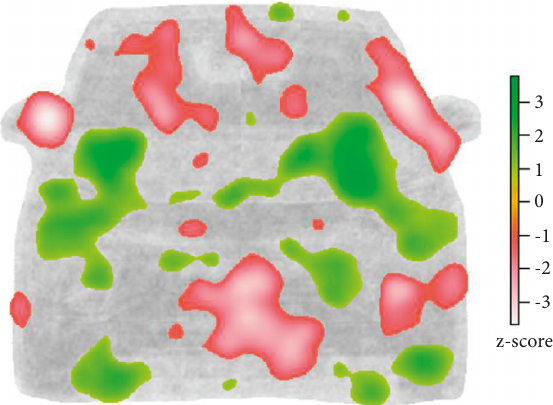
Figure 6: Z-map of the CI. Areas eliciting sports car perception are displayed in green, while those conveying the inverse perception are displayed in red and white.